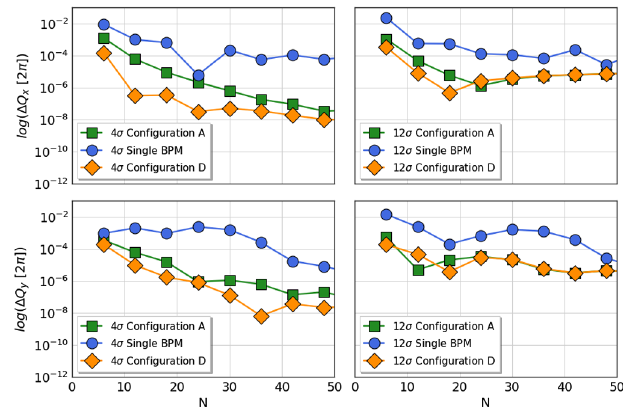
FIG. 12. The precision of the tune measurements for the horizontal (top row) and vertical (bottom row) planes. The results for the single-BPM analysis are shown in blue circles, the mixed BPM scheme with configuration A in green squares, and with configuration D in orange. The initial excitation of the beam corresponds to 4 σ (left column) and 12 σ (right